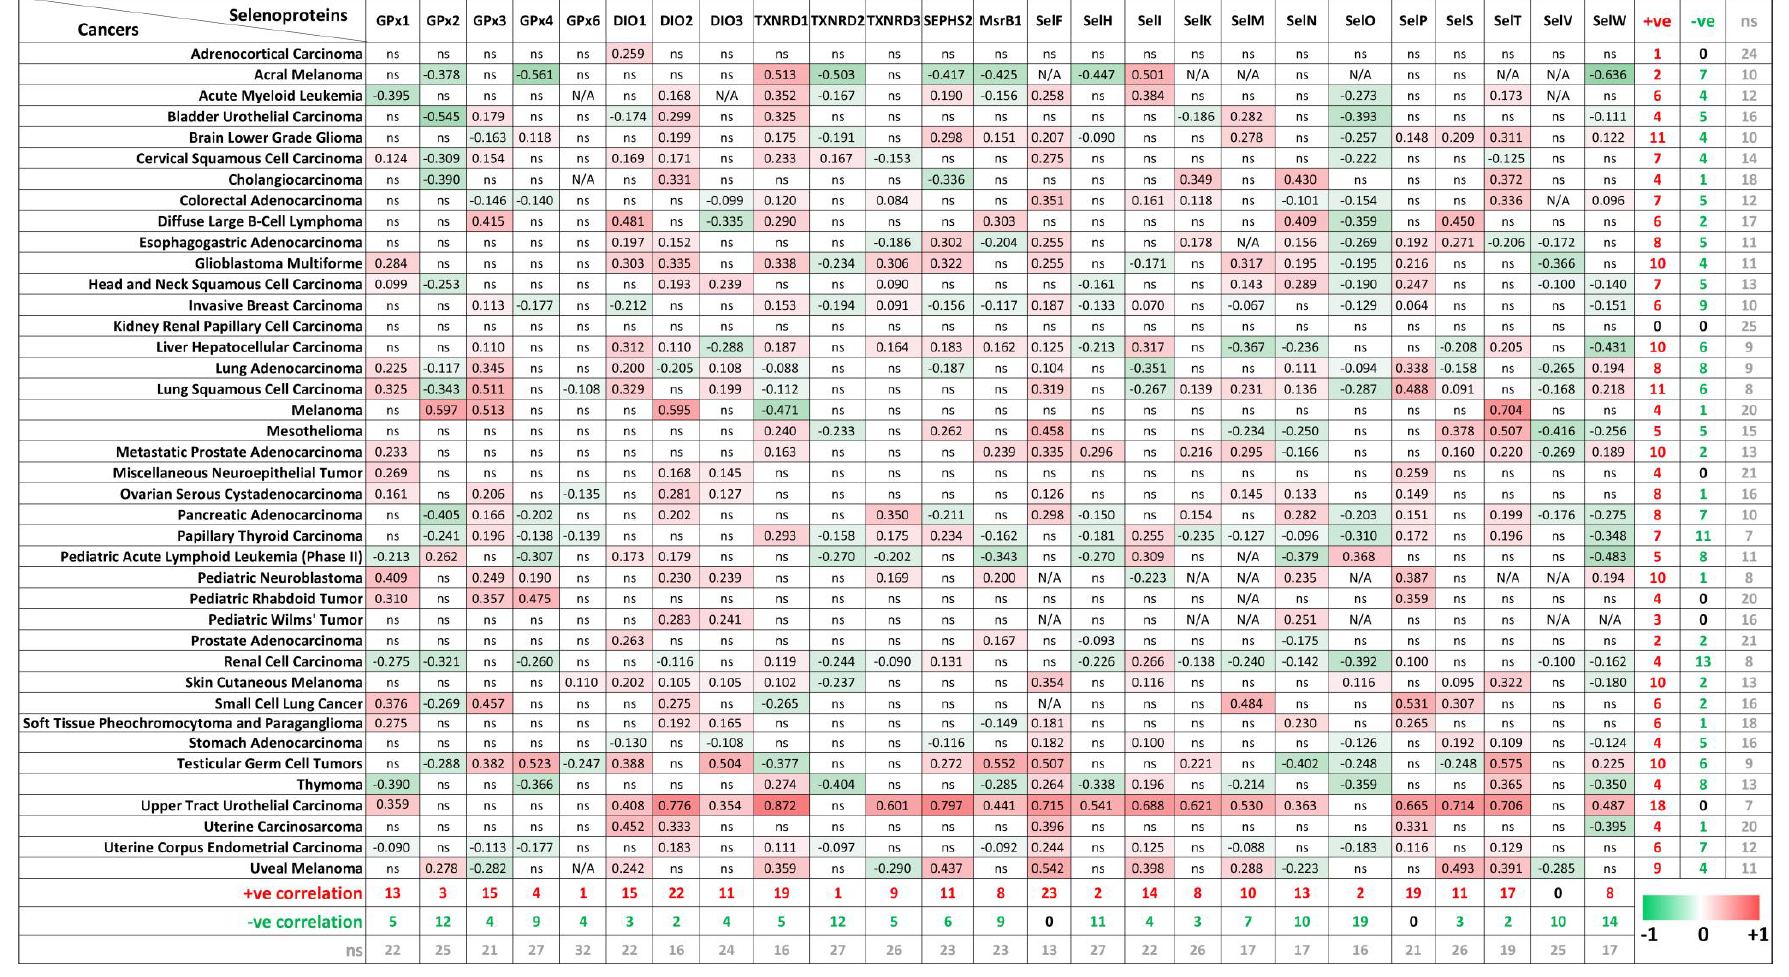
Figure 7. Co-expressions of ZIP8 and selenoprotein genes in cancers analyzed by spearman’s correlation. Co-expression data of ZIP8 and 25 selenocysteine-containing protein genes in 40 types of cancers were obtained from TCGA database. A spearman’s correlation value greater than 0 indicates a positive correlation (red) and value less than 0 indicates a negative correlation (green). Only values with p -value less than 0.05 were shown. ns: non-significant; N/A: not available.